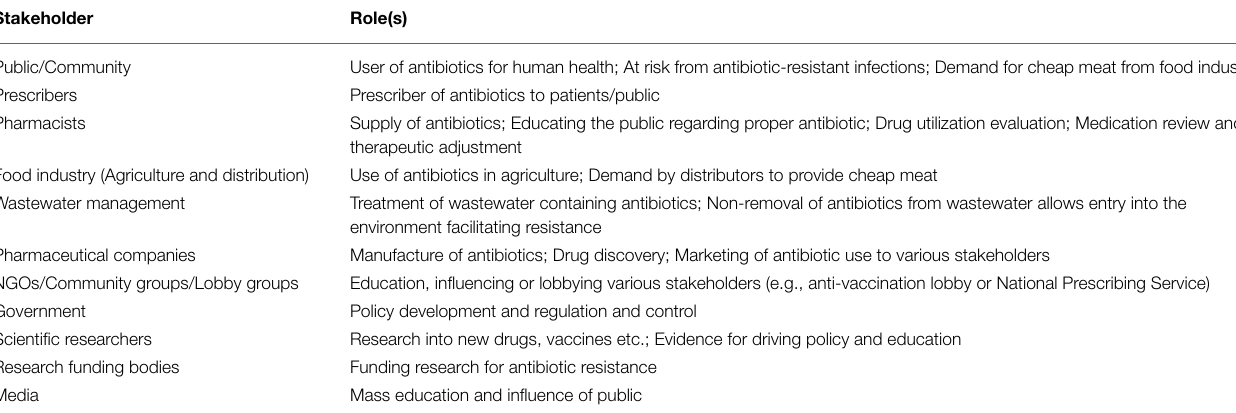
TABLE 1 | Representative list of stakeholders and their potential role(s) in